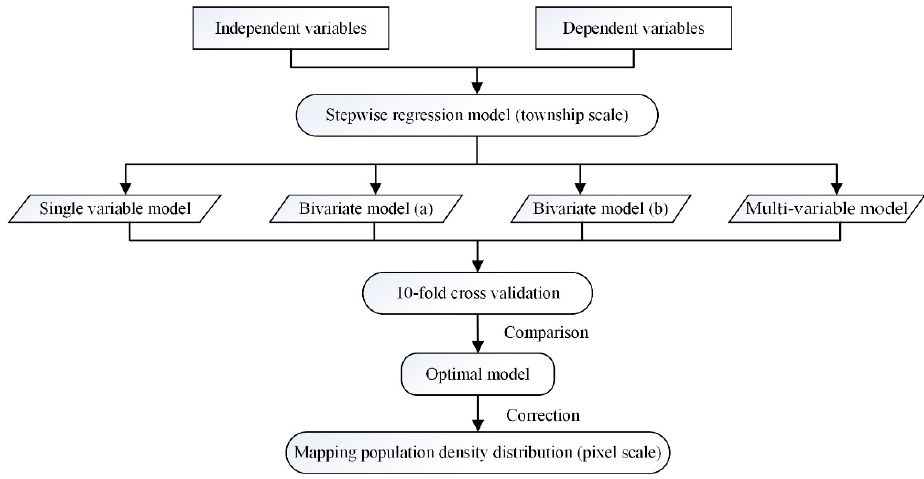
Figure 2. The flowchart of this study.